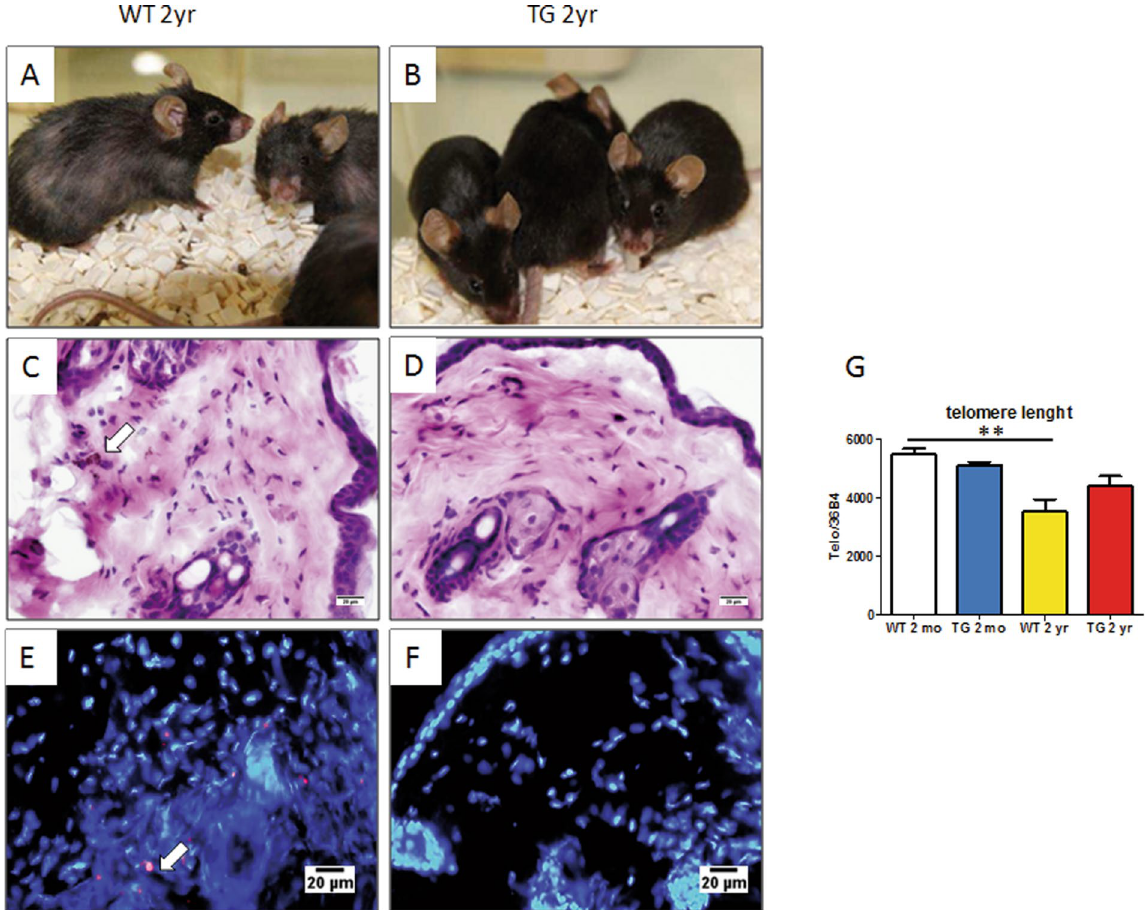
Figure 6. Calpastatin overexpression protects against skin aging. At 2 years, CalpTG (TG) mice ( B ) were phenotypically less impacted by aging than WT mice bred in the same conditions ( A ). There was a macroscopic evidence that CalpTG (TG) mice fur was less affected by aging than WT mice. In addition, we observed less lipofuscin deposits in the skin after hematoxylin eosin staining ( C,D , white arrow, magnification × 200) or by using lipofuscine autofluorescent properties ( E,F , white arrow, magnification × 200). Moreover, telomere lenght decreased significantly in WT mice skin but not in CalpTG skin ( G , ** p < 0.01, n =